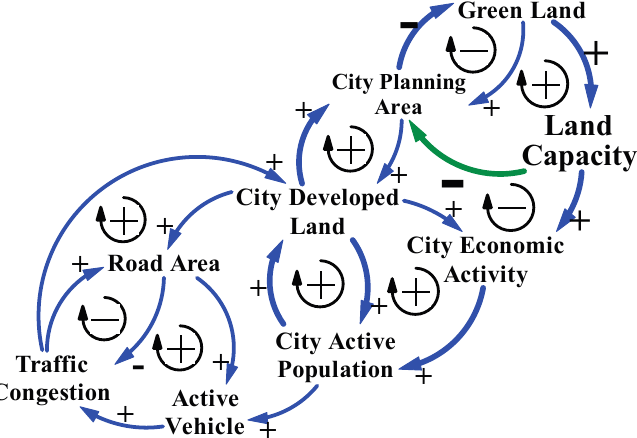
Figure 11. The conceptual S&D CLD model for reasoning city development and traffic congestion policies based on carrying